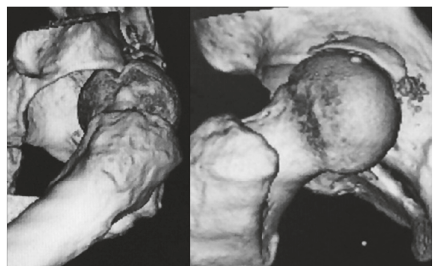
Figure 1: Computed tomography suggested a bone chip from the posterior wall of the acetabular roof and a depressed femoral head that cut into the posterior margin of the acetabular roof.